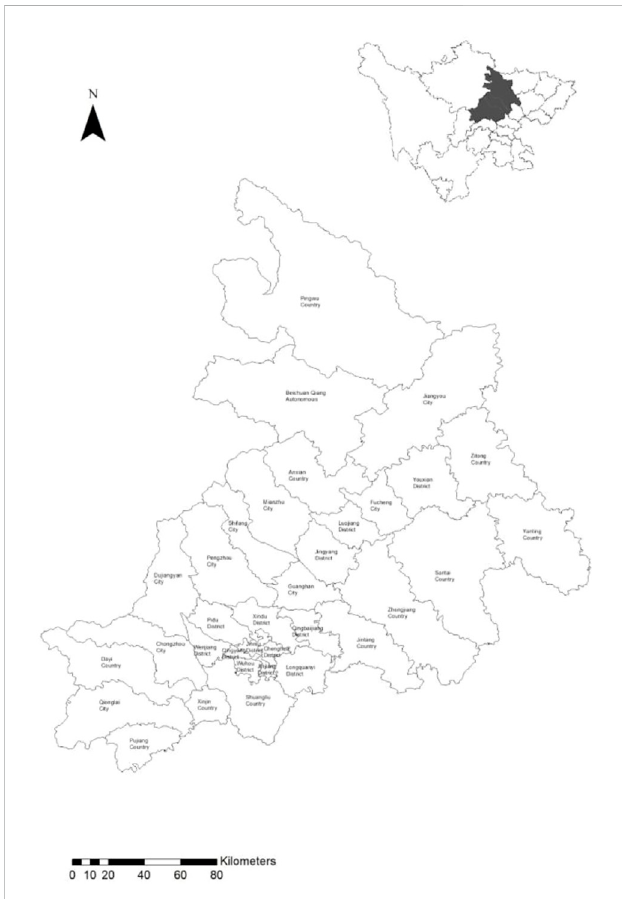
FIGURE 3 Schematic diagram of the scope and location of the study